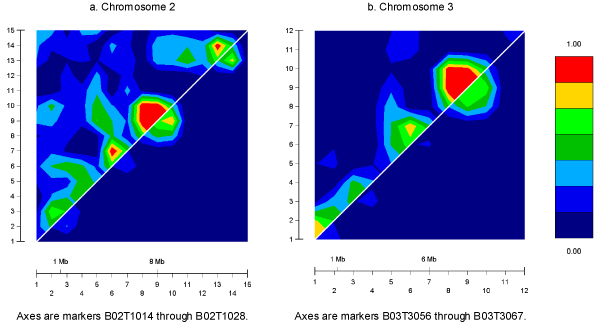
Pairwise disequilibrium coefficients: simulated LD present. |D'| above and r2 below diagonal